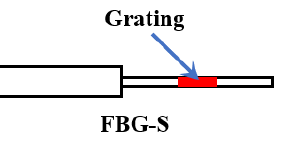
Figure 4. Two types of FBGs.